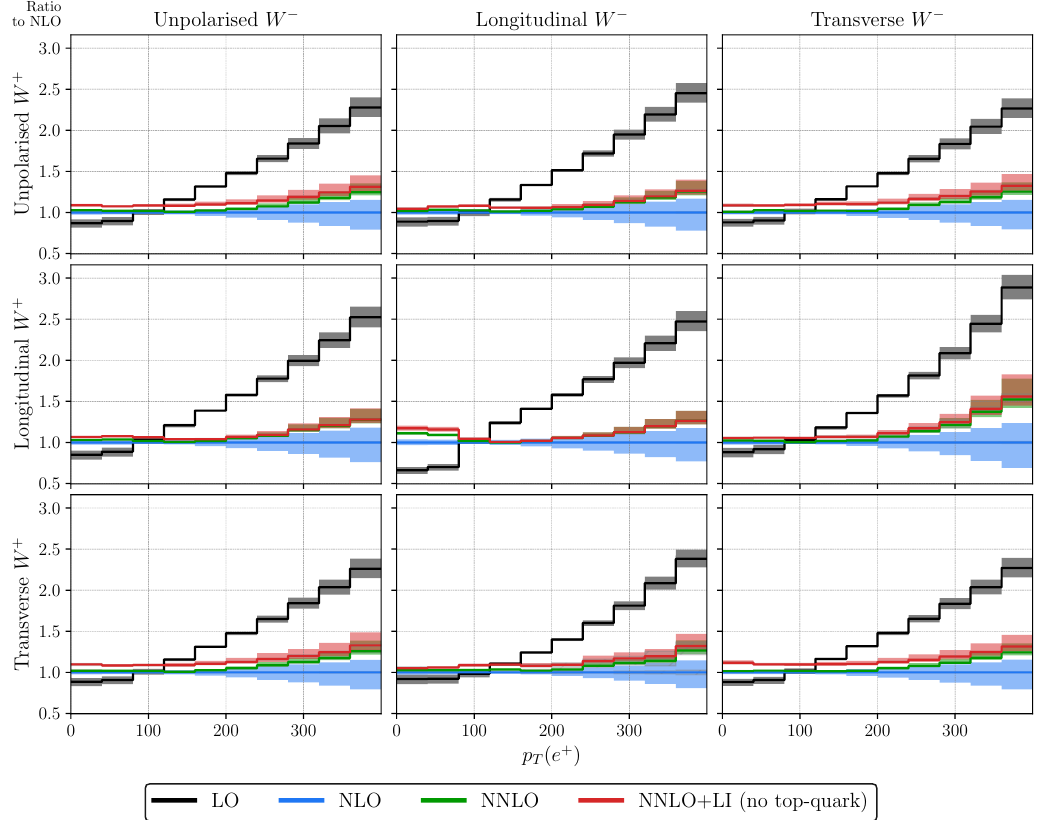
Figure 7 . Ratio to NLO of e + transverse momentum distribution at various orders of perturbative QCD with top-quark loop contribution removed. Same plot structure as in figure